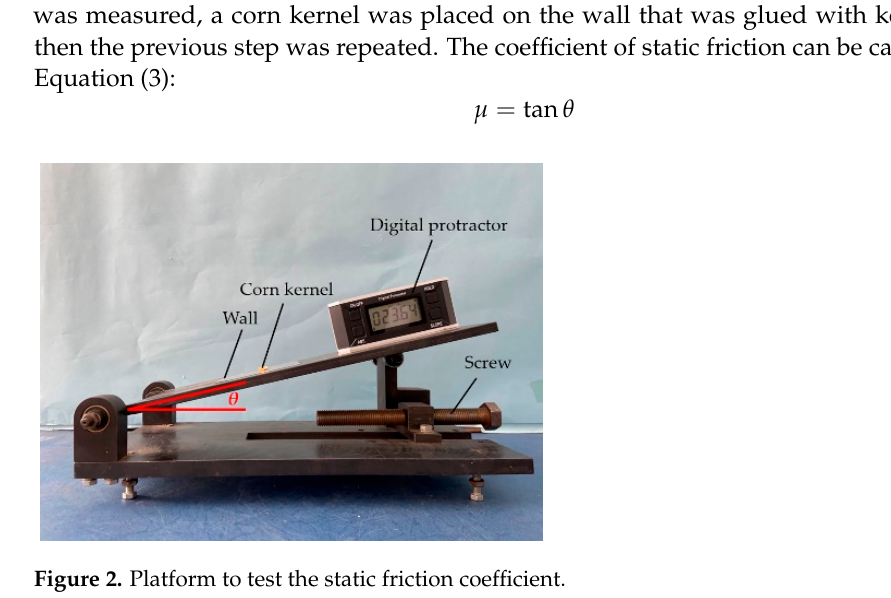
Figure 2. Platform to test the static friction coefficient.